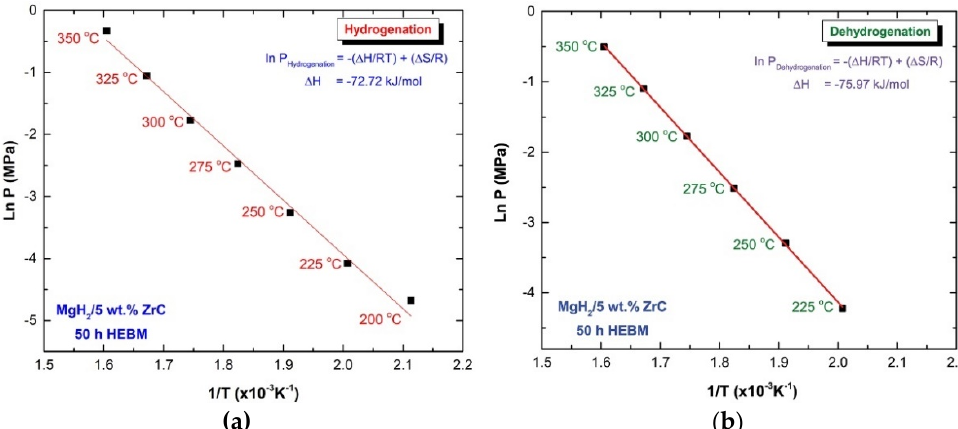
Figure 11. Van’t Hoff plot of the plateaus shown respectively in Figure 10 a for hydrogenation ( a ) and 10b dehydrogenation ( b ) of nanocomposite MgH 2 /5 wt.% ZrC obtained after 25 h of HEBM.